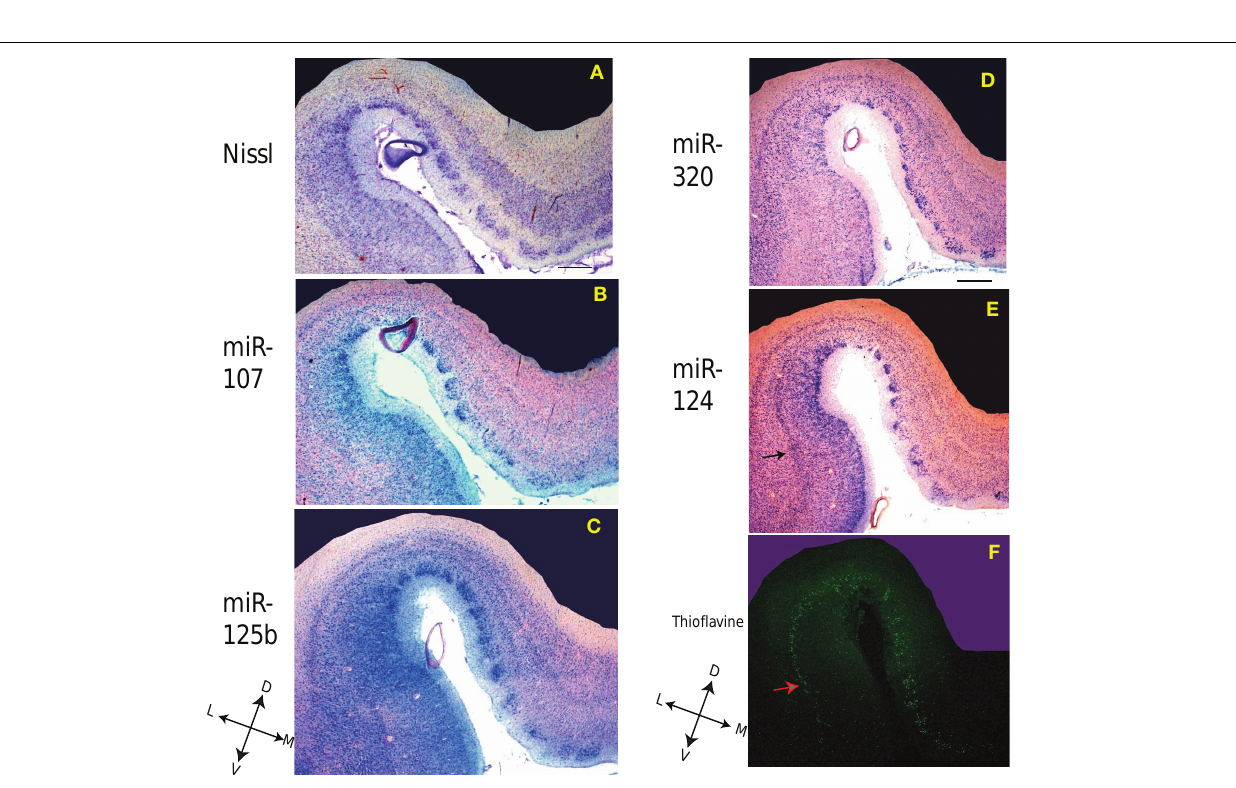
FIGURE 1 | In situ hybridization, Nissl, and Thiofl avine S stains for Case 1. (A) Nissl stain (B) miR-107 ISH (C) miR-125b ISH (D) miR-320 ISH (E) miR-124 ISH, and (F) Thiofl avine S (amyloid plaques and neurofi brillary tangles are